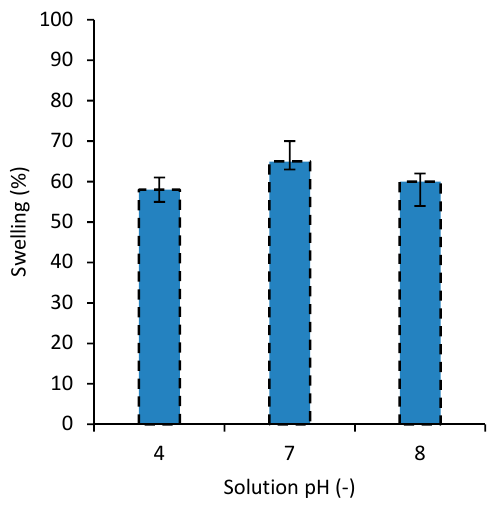
Figure 7. The degree of swelling for the nanocomposite in water with different pH levels.